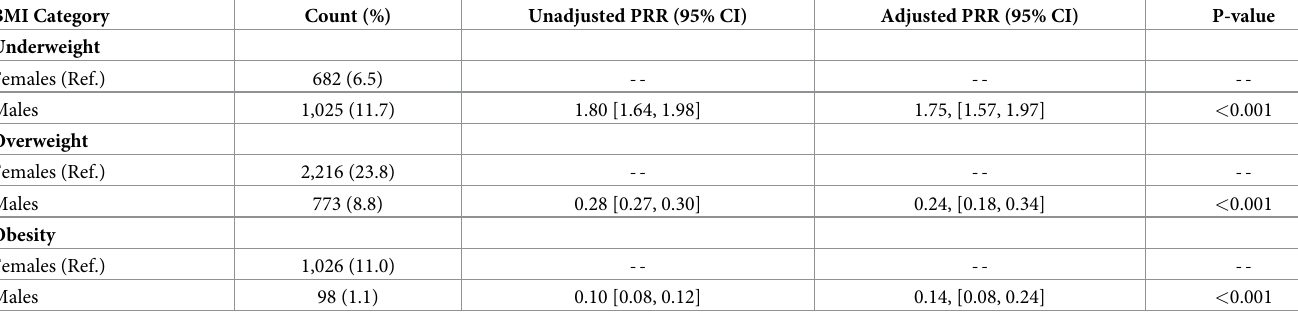
< 0.001 < 0.001 < 0.001